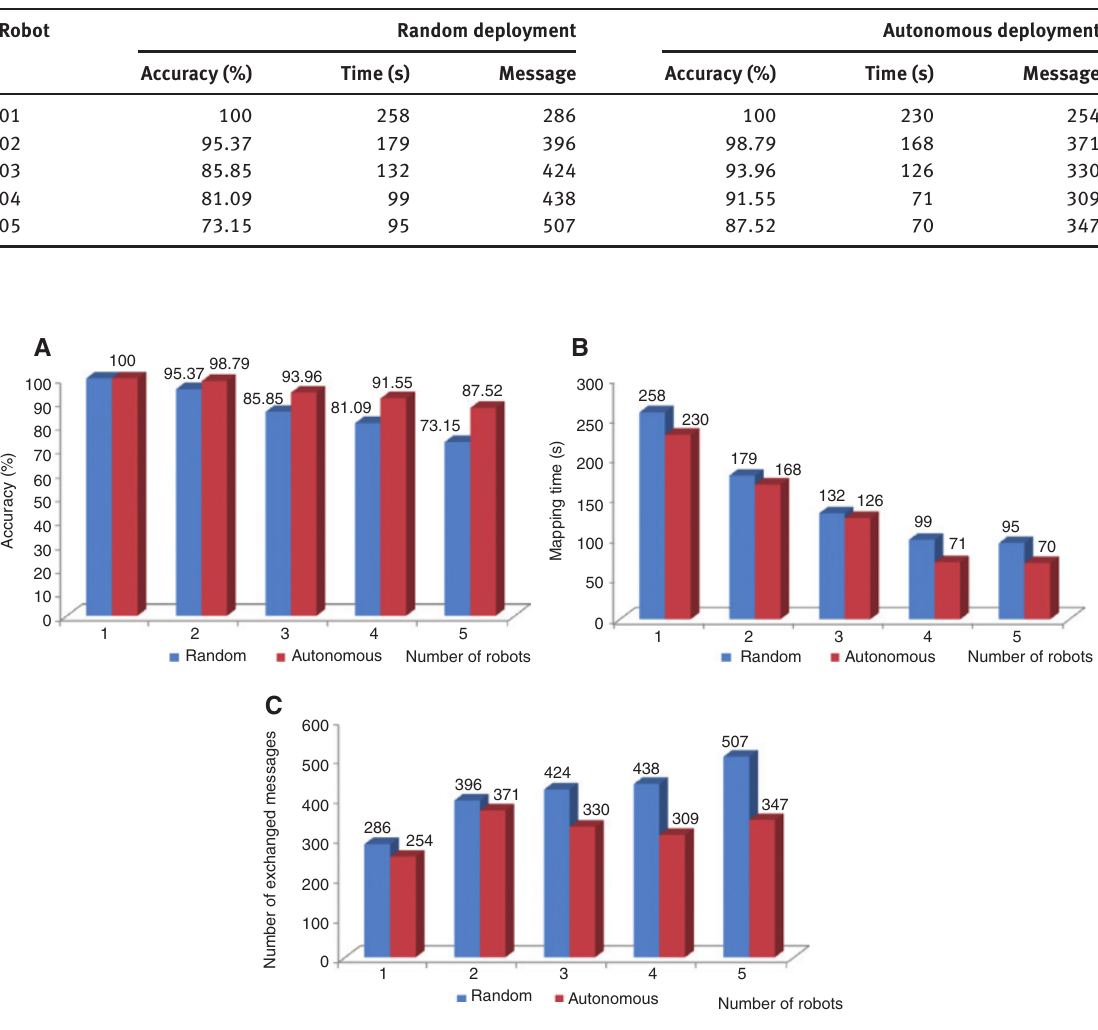
Figure 10: Average for 20 Trials of the Previous Scenarios: Accuracy of the Global Generated Maps, Time of Mapping, and Number of Exchanged Messages: (A) Mapping Time of the Generated Maps, (B) Number of Exchanged Messages, and (C) Accuracy of the Generated